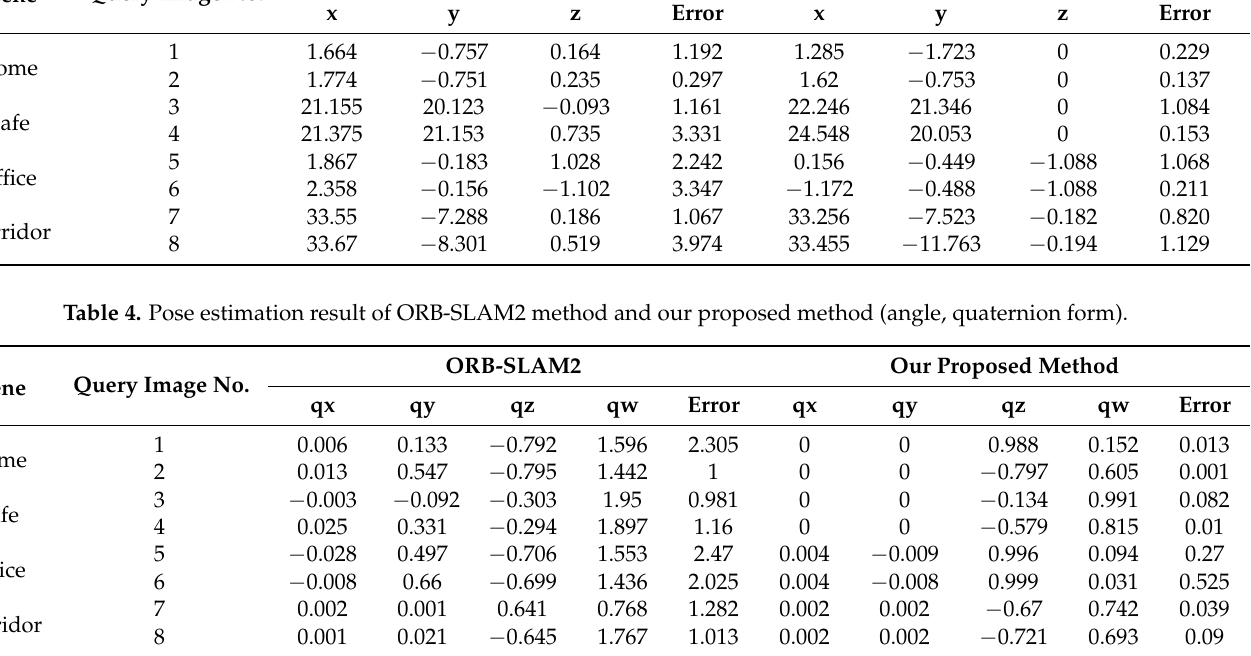
Table 3. Pose estimation result of ORB-SLAM2 method and our proposed method (position, unit: m). Scene Query Image No.